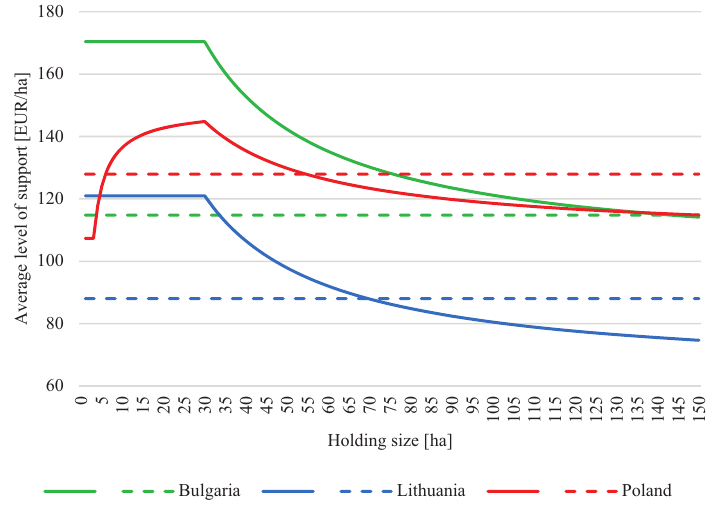
Figure 2. The impact of the redistributive payment on the average level of support in absolute terms, depending on the size of the holding (2018) (source: author’s own work on the basis of data provided by the Ministry of Agriculture, Food and Forests of the Republic of Bulgaria, the Ministry of Agriculture of the Republic of Lithuania, and the Ministry of Agriculture and Rural Development of the Republic of